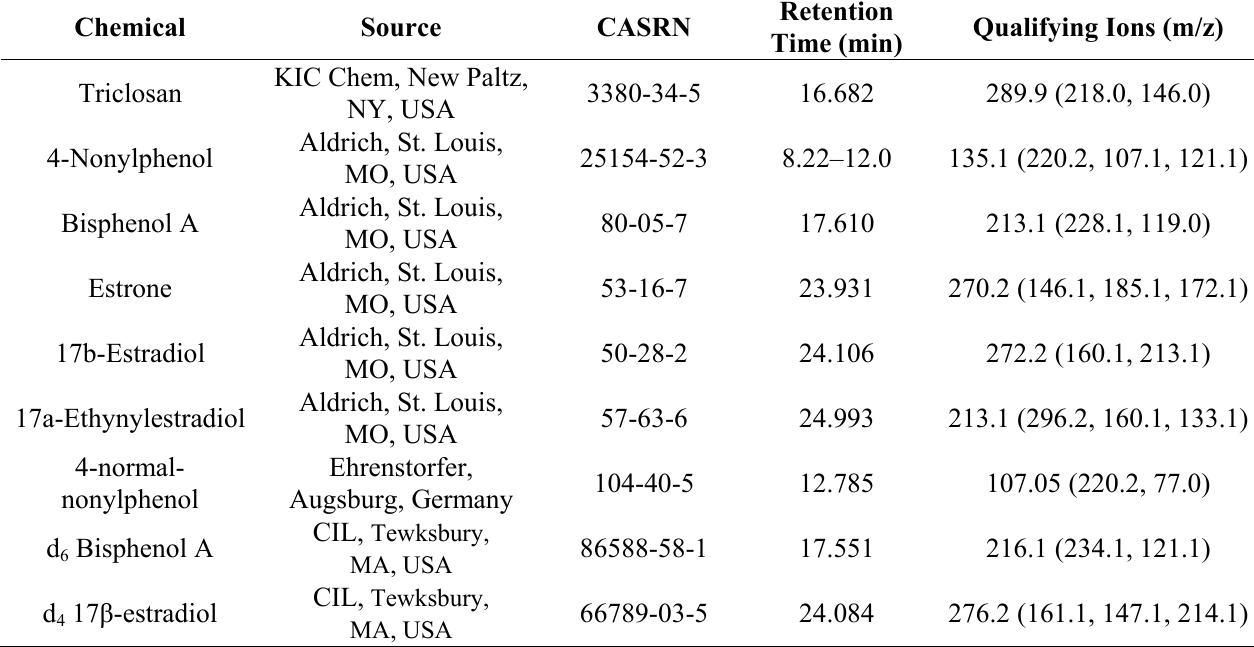
Table 1. Chemical source, Chemical Abstract Services Registry Number (CASRN), Gas Chromatography Mass Spectrometry (GC/MS) retention times, and chemical indicator ions, with qualifying ions used for peak identification in parentheses.